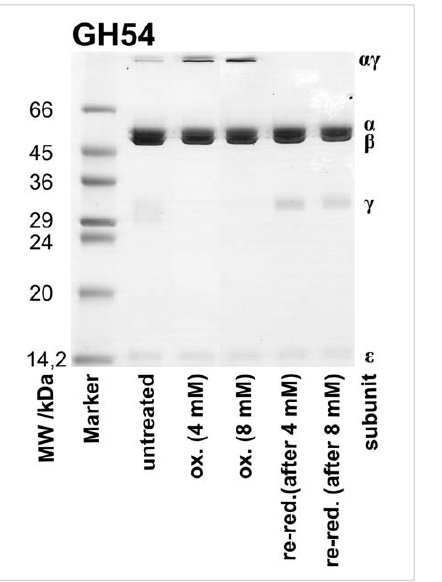
Figure 4. Rotary trajectories of reduced and oxidized F 1 molecules. Trajectories of three active single molecules of GH54 driven by ATP hydrolysis both in the reduced (dashed line) and in the oxidized (dotted line) state, respectively. The mean trajectories for each of both states are shown by the solid lines.